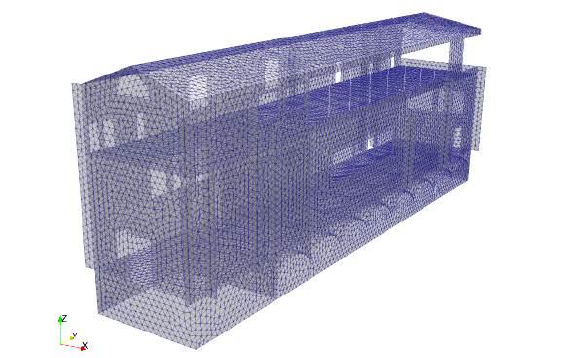
Figure 5. The mesh created for the finite element model of the “Sala dei Gessi”.